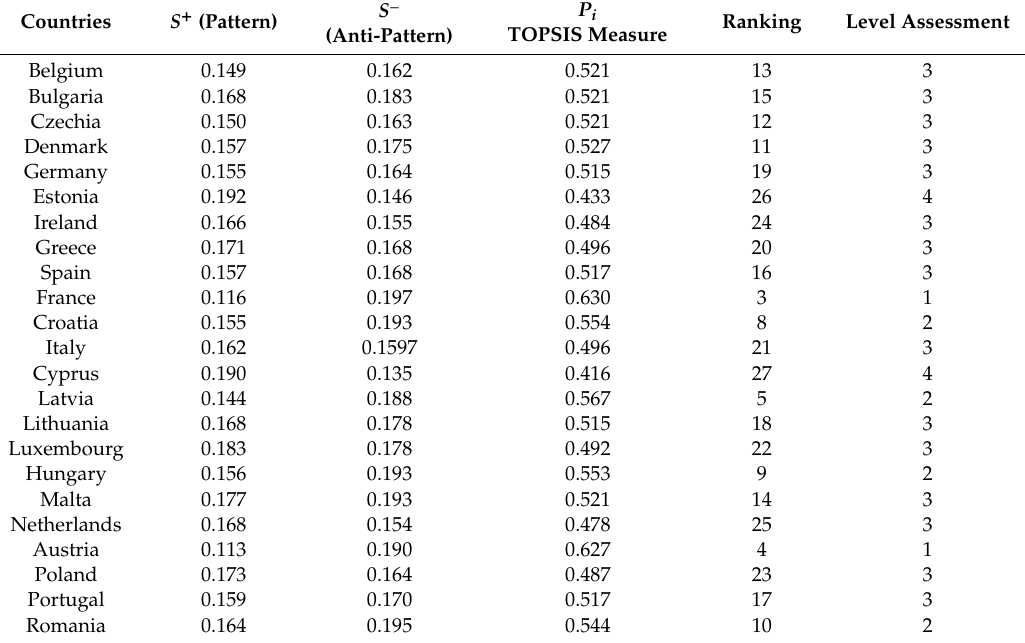
Figure 9. Ranking and level assessment of the EU-27 countries in terms of sustainable energy development, including the number of their inhabitants ( a ) ranking, ( b ) level assessment. Table 6. Distance of the EU-27 countries from the ideal and non-ideal solutions together with the TOPSIS measure of sustainable energy development, including the number of inhabitants.